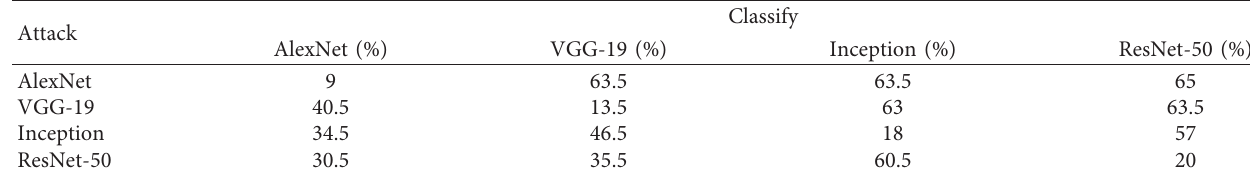
Table 4: The classification accuracy (our